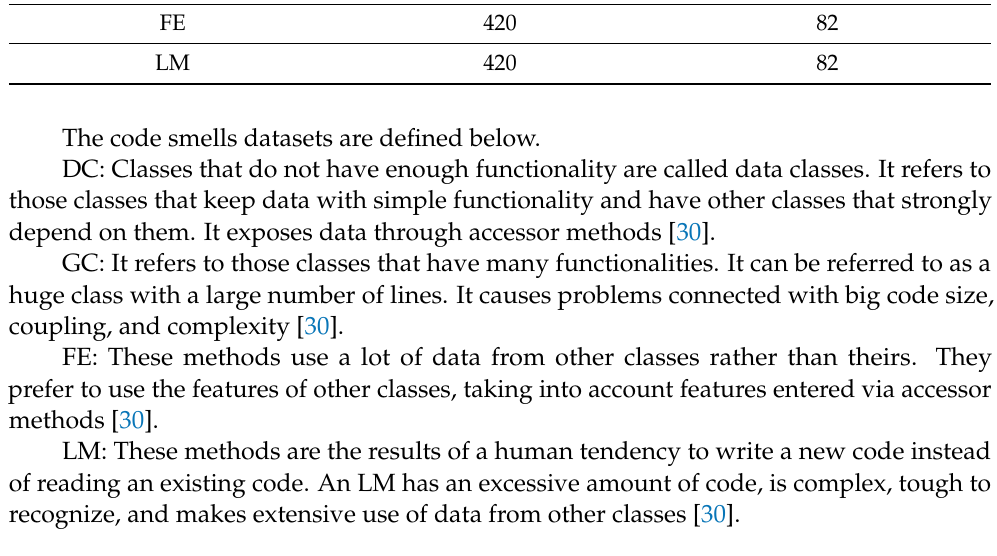
Table 3. Class level and method level code smells datasets [23]. Code Smell Dataset Samples Selected Metrics DC 420 61 GC 420 61 FE 420 82 LM 420 82 The code smells datasets are defined